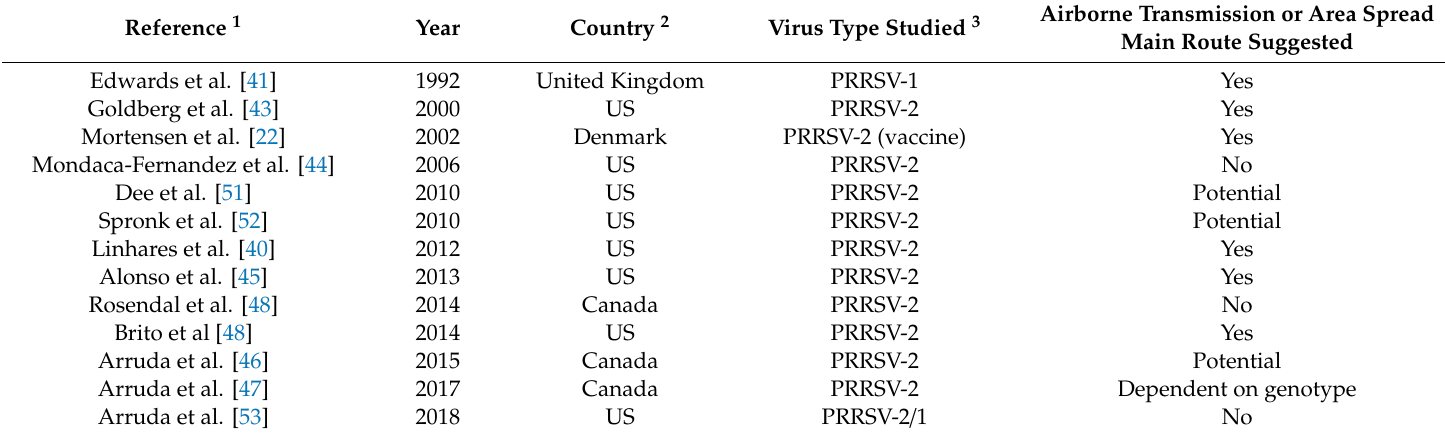
Table 2. Summary of peer-reviewed publications of field-based studies assessing area spread or airborne transmission of porcine reproductive and respiratory syndrome virus